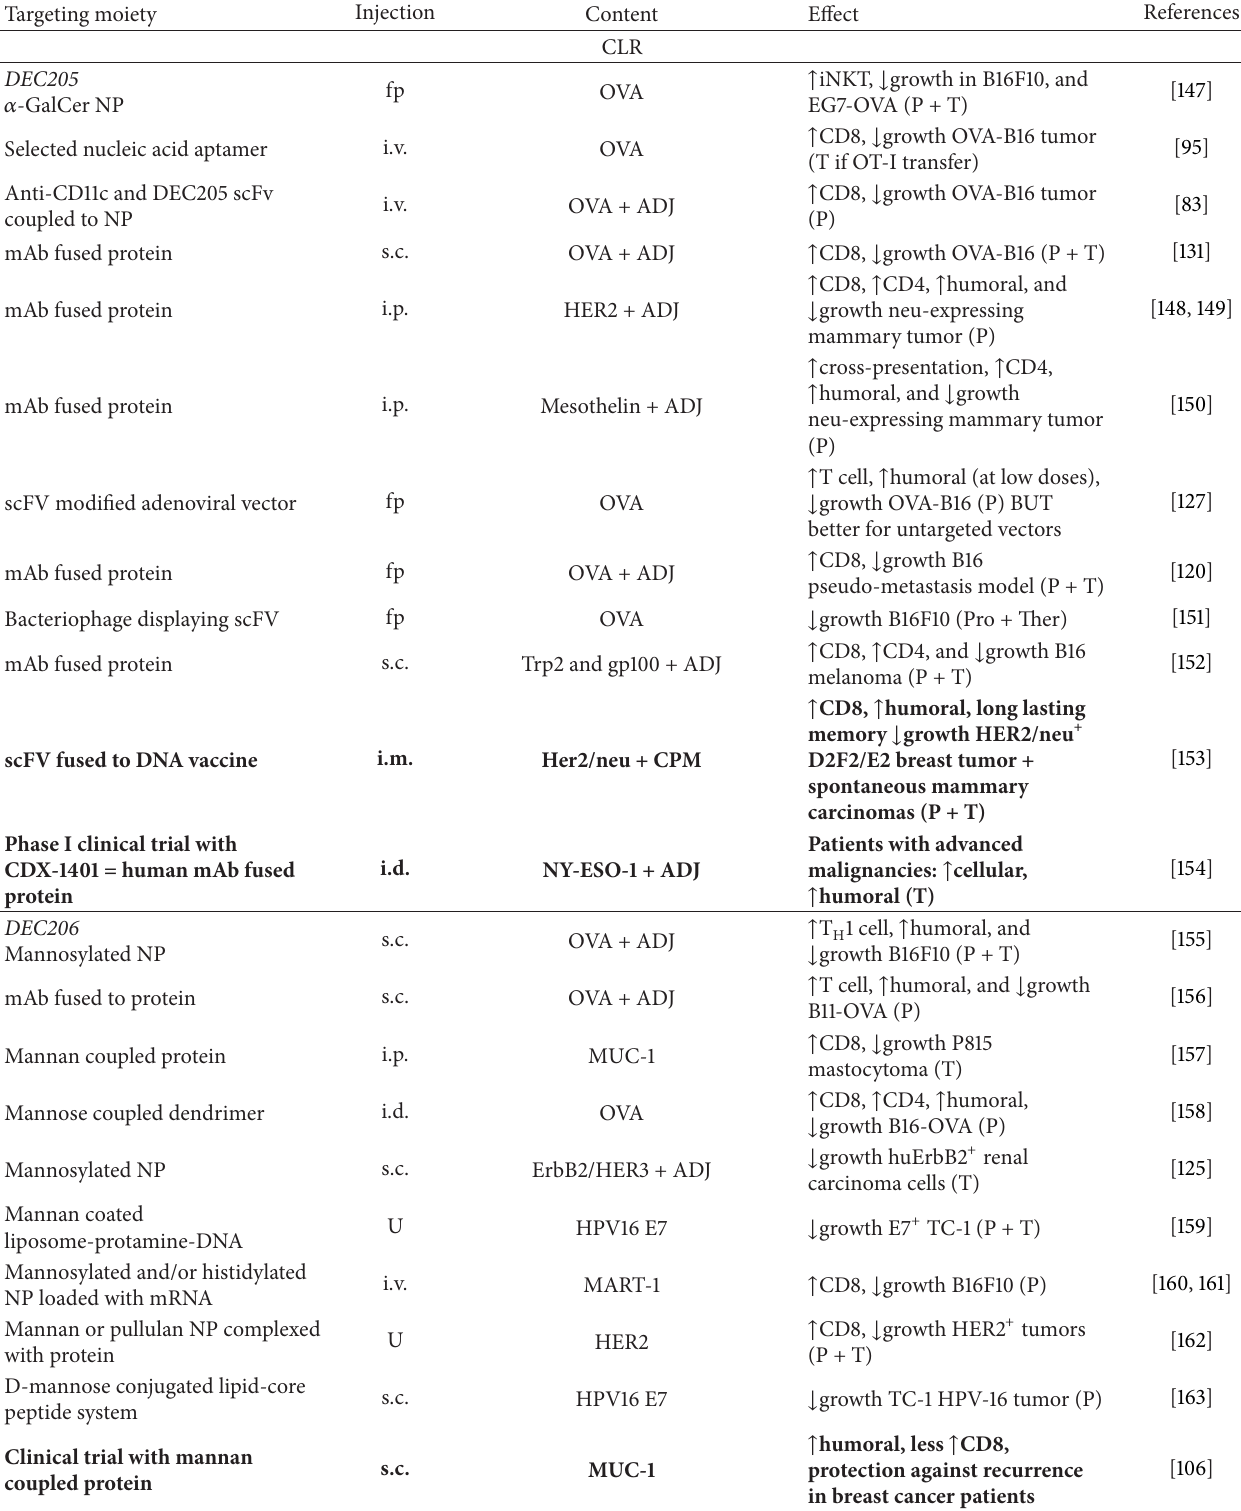
Table 2: Summary of in vivo APC targeting studies in the framework of antitumor